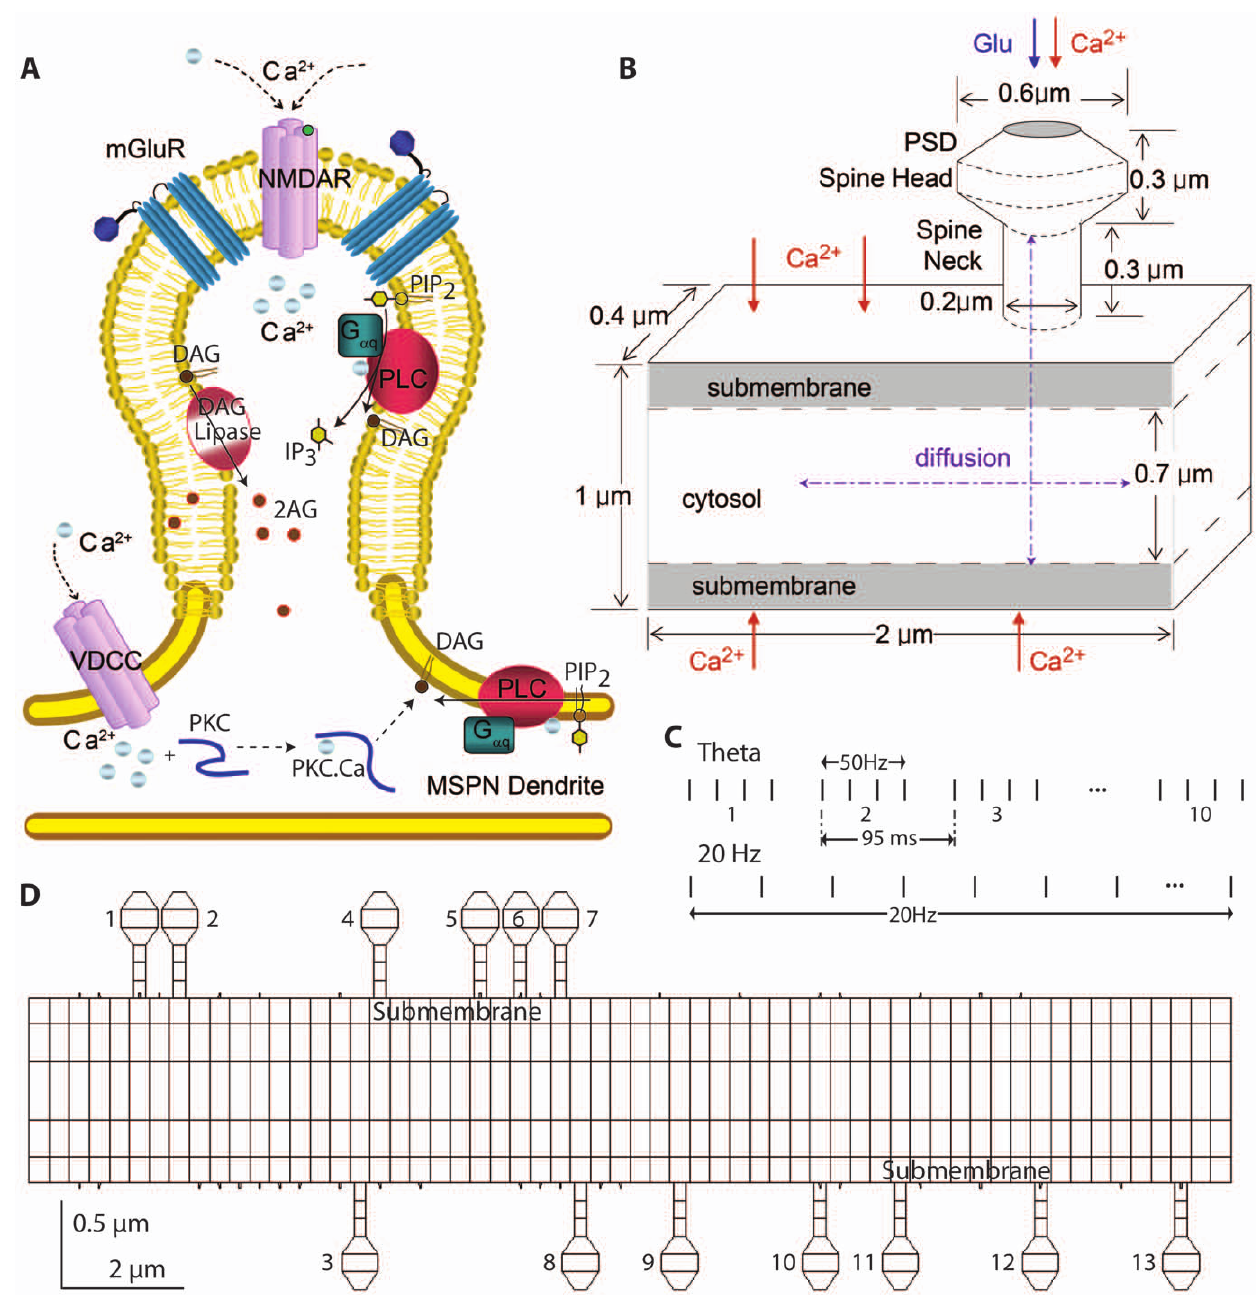
Figure 1. Morphology and signaling pathways in the model. (A) Glutamate binds to metabotropic glutamate receptors (mGluR), which activate the Gq subtype of G protein. Calcium, in the absence or presence of activated G a qGTP, binds to and activates phospholipase C (PLC), which produces diacylglycerol (DAG) and inositol trisphosphate (IP 3 ). Diacylglycerol lipase (DAGL) converts diacylglycerol to 2-arachidonyl glycerol (2AG), an endocannabinoid implicated in both LTD and DSI. Alternatively, calcium and then DAG bind to protein kinase C (PKC), forming the activated form, implicated in LTP. (B) For most simulations, the morphology consists of a single spine and a 2 m m length of dendrite. Calcium influx into the postsynaptic density (PSD) represents influx through both NMDA receptors and voltage dependent calcium channels in the spine, and calcium influx into the dendrite represents voltage dependent calcium channels. Glutamate or DHPG (a metabotropic receptor glutamate agonist) is provided to the PSD. (C) Stimulation patterns used for theta burst and 20 Hz stimulation. A single train is illustrated for both stimulation patterns. (D) Several simulations used a 20 m m long dendrite with 12 spines. Reactions and initial conditions are the same as for the smaller morphology. Spine numbering is used for Fig. 9 and